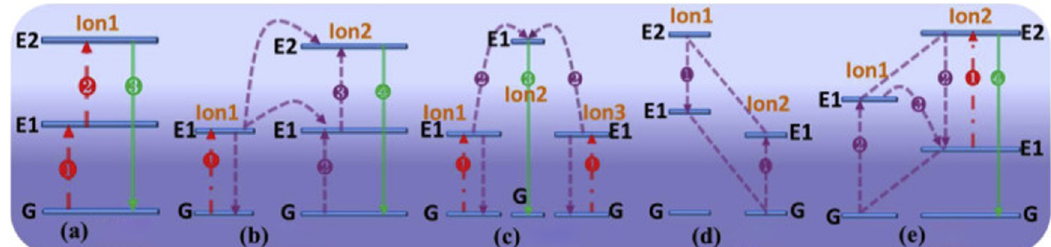
Figure 1: UCL type [ 146 ] ; ESA; ETU; PA; CSU;